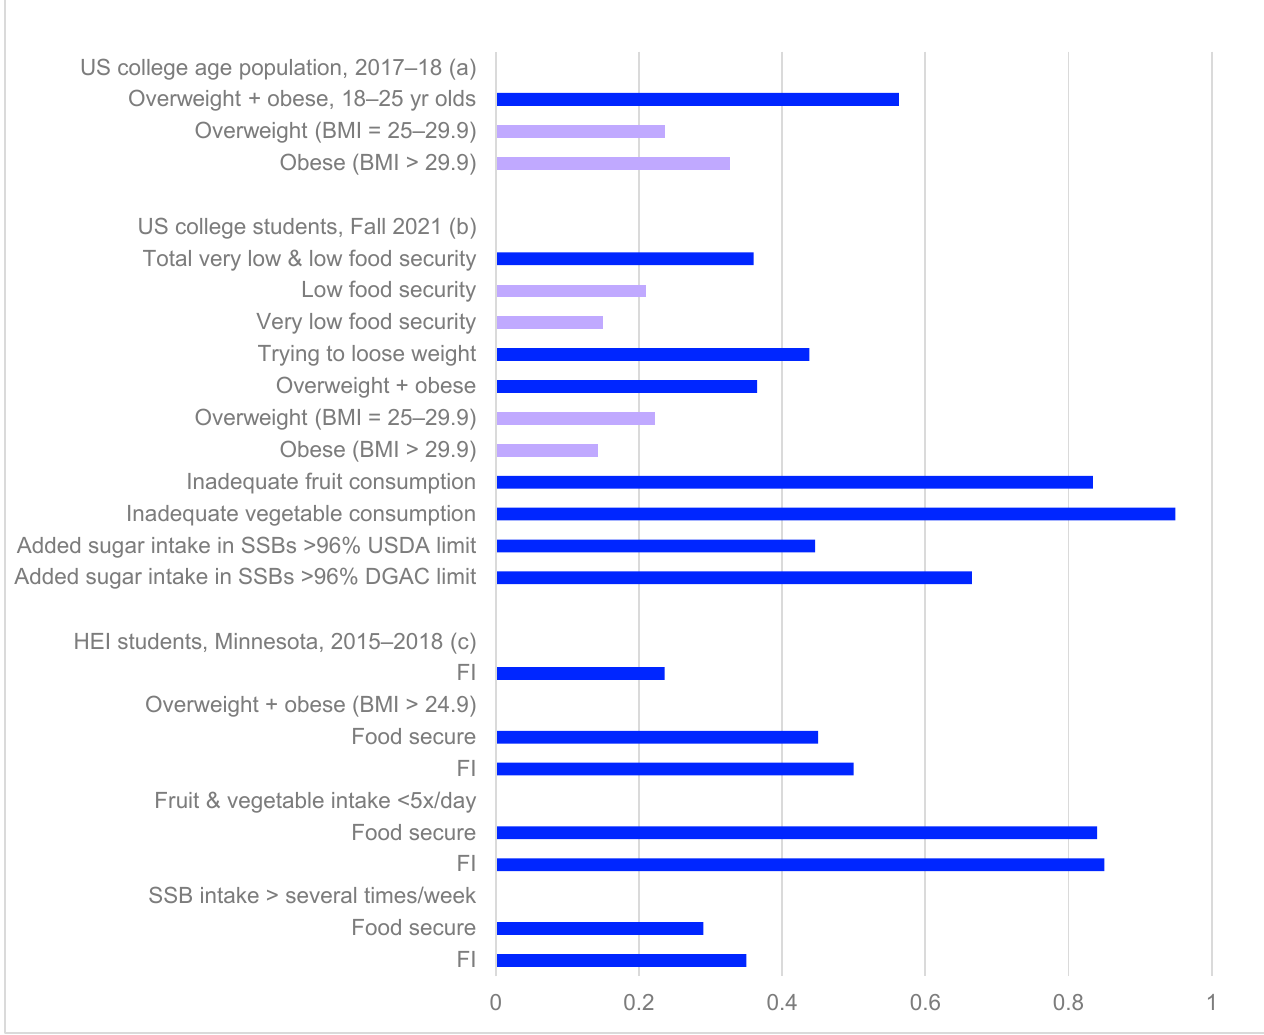
0 Figure 4. Health of US higher education students. © D.A. Cleveland, used with permission. ( a ) Data from [54] for NHANES sample, n = 383. ( b ) Based on data from the National College Health Assessment III [55], n = 31,188 to 32,315. Intake of added sugar in SSBs is for a 2000 kcal/day diet, compared with the recommended limit for the amount of added sugar recommended by the DGA (10% of calories), and by the Dietary Guidelines Advisory Committee (5% of calories) [56]; the amount consumed in SSBs alone for 48% of students was 96% the DGA limit of 10% of calories, and for 96% of students was 96% of the limit of 5% of calories [56]. I assumed 24.1 g of added sugar in a 12 oz SSB [59], and 4 kcal/gram. Adequacy of fruit and vegetable consumption in comparison to US Dietary Guidelines for Americans (DGA) recommended intake of 2 and 2.5 cups of fruit and vegeta- bles per day, respectively [60], 83% had inadequate fruit, and 95% inadequate vegetable consumption. ( c ) Data from [58]; survey of students in 27 HEIs (including 22 PHEIs) in Minnesota, US, n =